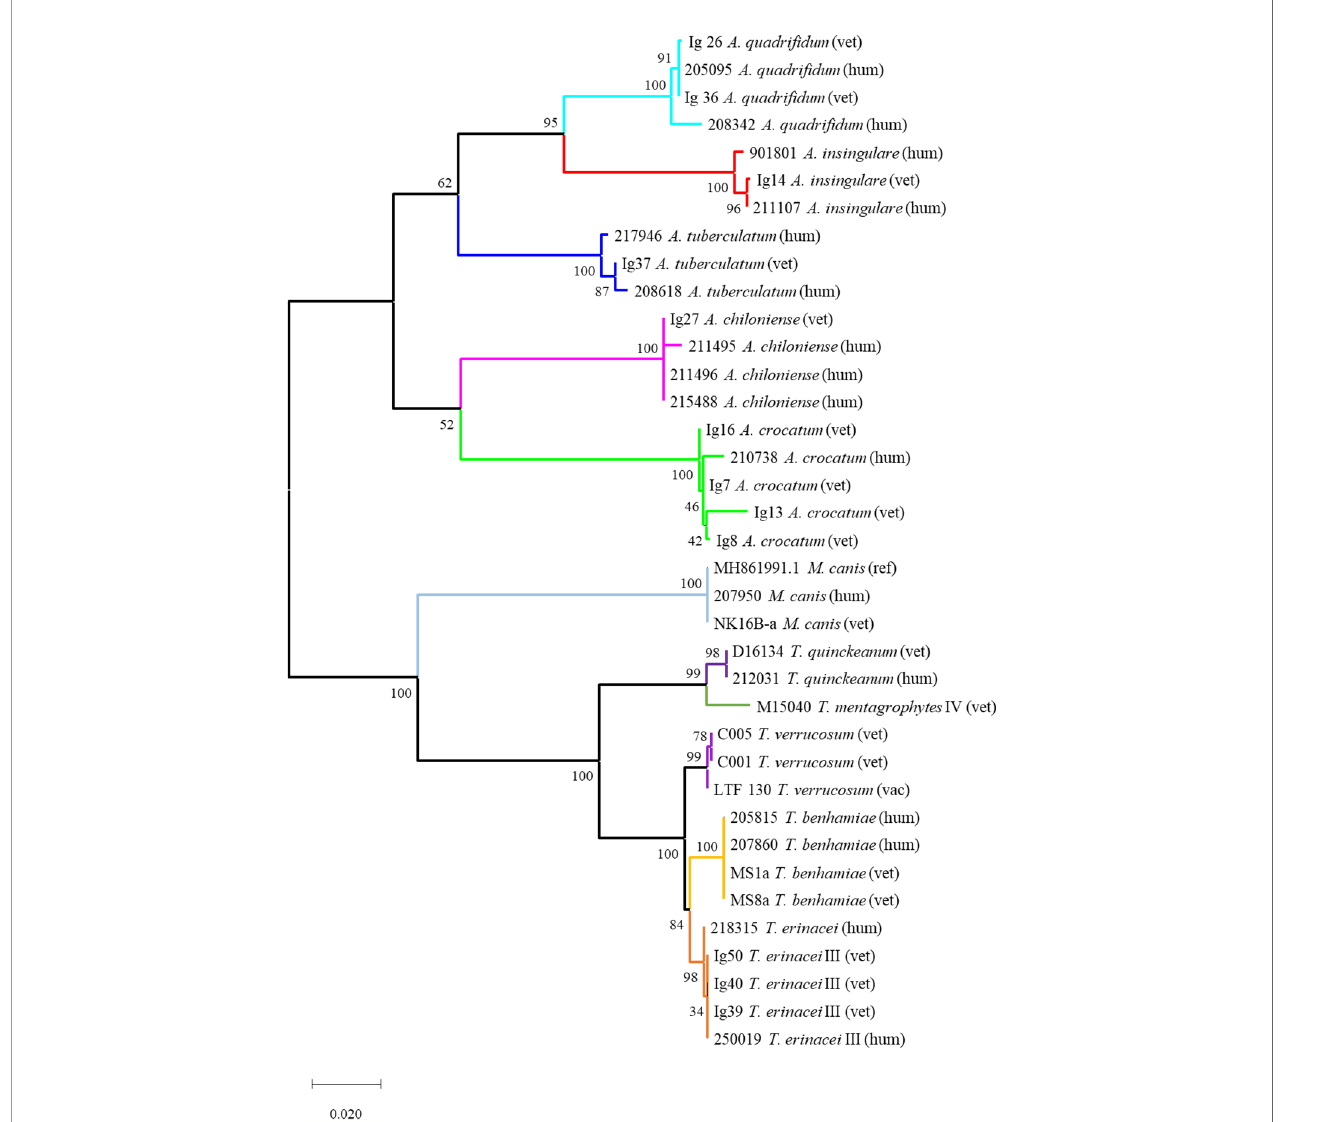
FIGURE 2 | Phylogenetic tree based on fungal rDNA ITS sequences for the investigated dermatophyte isolates (Tamura-Nei-model, Neighbor-Join and BioNJ algorithms, MCL approach, 1000 replicates). The tree is drawn to scale with branch lengths measured in the number of substitutions per site and indicated support values; the analysis involved 37 nucleotide sequences including the dermatophytes isolated during this study and from veterinary routine diagnostics (vet; vac refers to a vaccine strain used in bovine practice), human-derived isolates from the Laboratory of Medical Microbiology (hum) and sequences derived from the NCBI database. Generally, each dermatophyte species forms an own subclade with mostly very robust support; the different origins of isolation (vet vs. hum) are not re fl ected. The tree comprises two main clades: the upper one contains all geophiles, i.e. all Arthroderma spp.; the lower one all isolates of the genera Trichophyton and Microsporum . The latter form individual subclades in this lower clade; the very closely related species T. benhamiae and T. erinacei as well as T. mentagrophytes and T. quinckeanum are separated in distinct